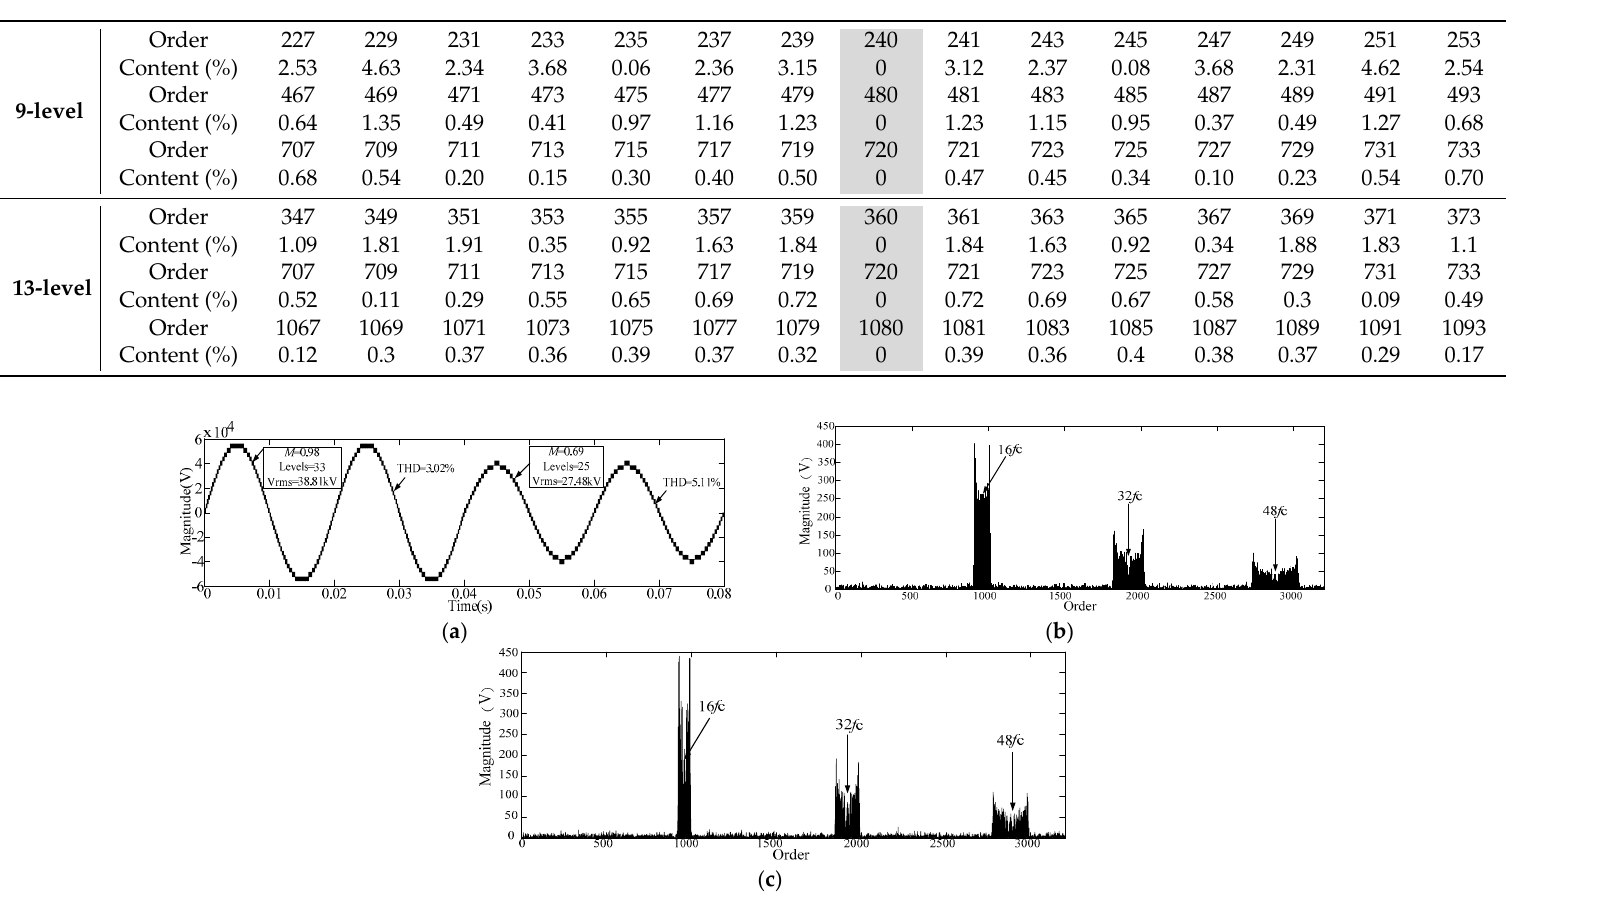
Figure 8. Simulation Results of an eight modules cascaded inverter with carrier phase shifted phase opposition disposition SPWM. ( a ) Output waveform. ( b ) Output spectrum ( M = 0.98). ( c ) Output spectrum ( M = 0.69).